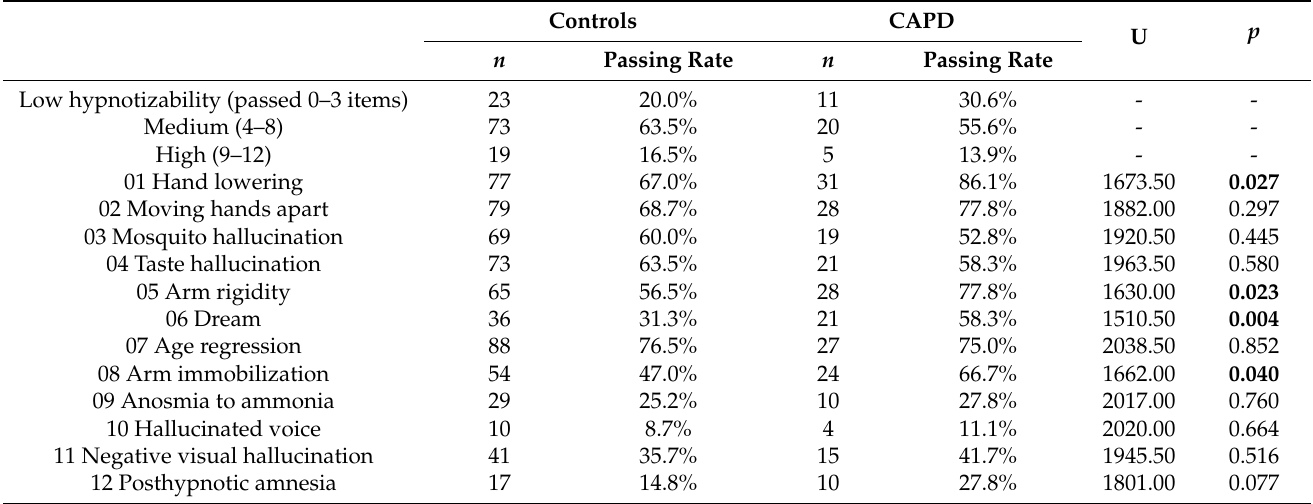
Table 1. The distributions of participants who passed the hypnotic susceptibility tests in healthy volunteers (controls, n = 115) and cluster A personality disorders (CAPD, n =